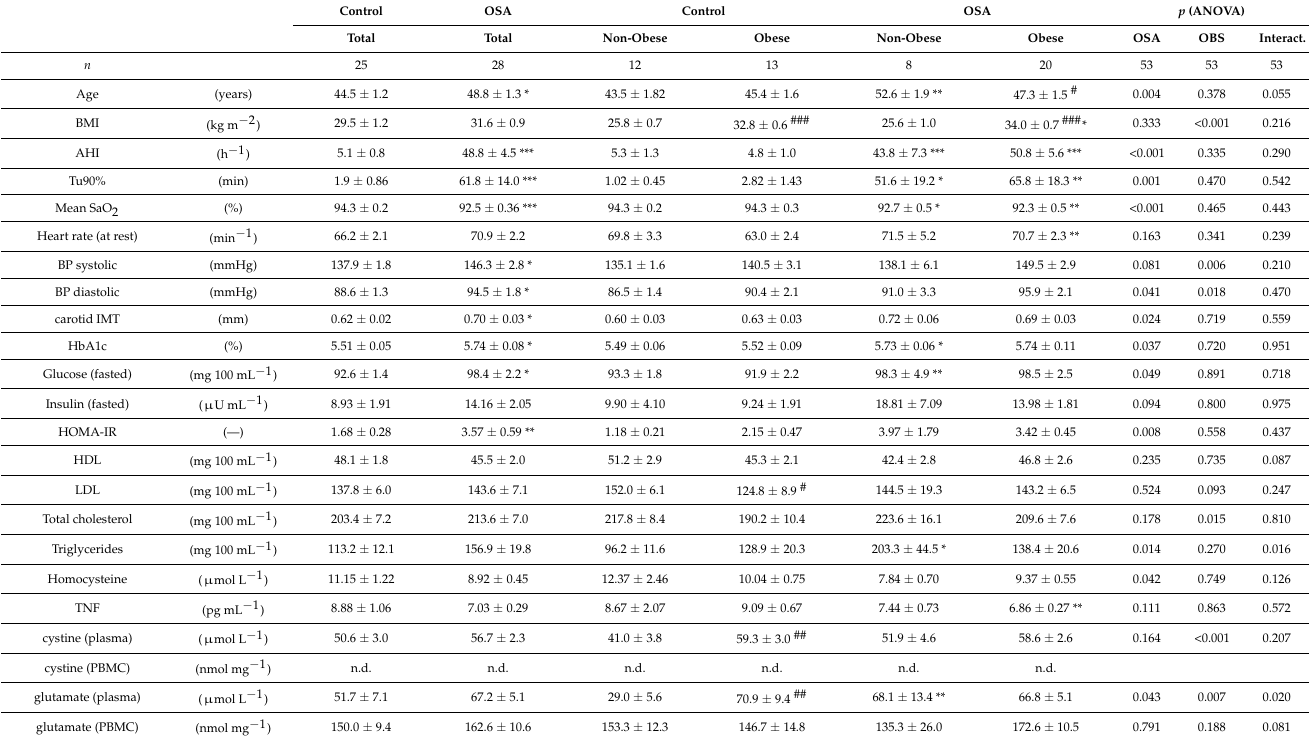
Table 1. Cross-sectional comparison between OSA patients (AHI < 15 h − 1 ) and controls with stratification for non-obese and obese BMI: Anthropometry, polysomnography, vascular risk factors, cystine, as well as glutamate, glycine, and